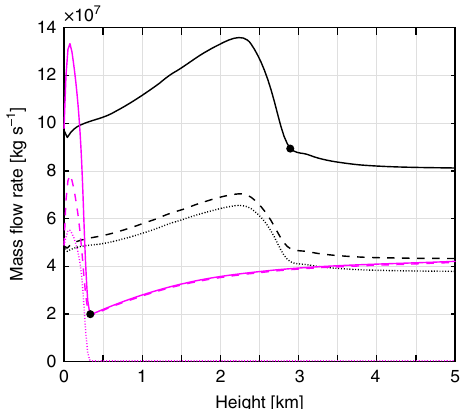
Fig. 6 Mass fl ow rate patterns in case studies. Mass fl ow rates in the ascending column integrated over time and space (across horizontal cross- sections at different heights). Magenta and black lines indicate the mass fl ow rate of the near total collapse and partial column collapse end- members, respectively. Solid lines represent the sum of the mass fl ow rate of the coarse and fi ne particles. Dashed and dotted lines represent the mass fl ow rate of the fi ne and coarse particles, respectively. Black dots represent the height of collapse H